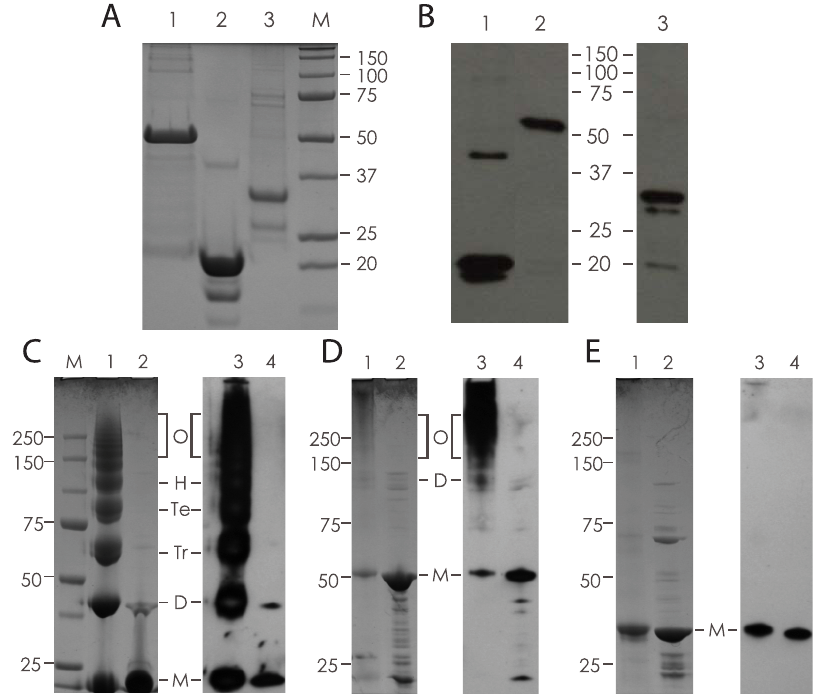
Figure 2. Expression, purification and chemical crosslinking of recombinant proteins. A) Coomassie Blue staining of purified, His-tagged proteins separated by 12% SDS-PAGE; 1. Acr-Ag85B (50 kDa), 2. Acr (20 kDa) and 3. Ag85B (32 kDa). B) Western blot analysis using antigen-specific antibodies; 1. Acr, 2. Acr-Ag85B and 3, Ag85B (1 and 2 probed with anti-Acr mAb TBG65; 3 probed with rabbit anti-Ag85B serum). C) Chemical crosslinking of Acr; shown is a Coomassie-stained (1, and 2) or Western blot (3 and 4) analysed sample with crosslinker (1 and 3) or without crosslinker (2 and 4). Letters indicate various molecular forms based on expected size (M-monomer, D-dimer, Tr-trimer, Te-tetramer, H-hexamer, O-oligomers). D) Chemical crosslinking of Acr-Ag85B fusion protein; shown is a sample with (1 and 3) or without (2 and 4) crosslinker. Letters indicate various molecular forms as for Acr (C). E) Chemical crosslinking of Ag85B (internal control); Coomassie and Western blot analysis of a sample with (1 and 3) or without (2 and 4) crosslinker.